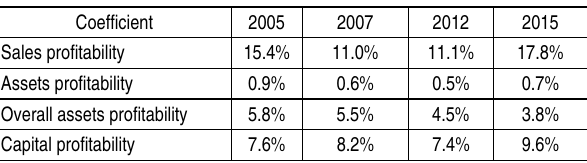
Table 6. The dynamics of financial results